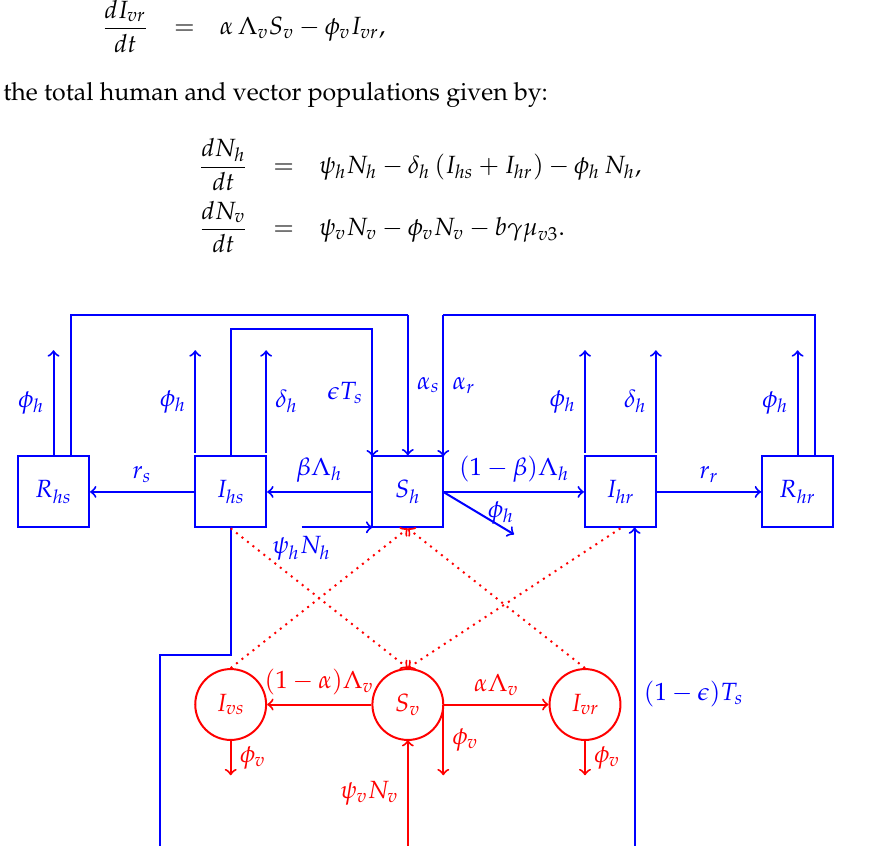
Figure 1. Susceptible humans S h can be infected by infectious mosquitoes. They then move to the respective infectious compartments, I hs , I hr , before entering the recovered classes R hs , R hr , respectively. Recovered humans can enter the susceptible class again or die. The susceptible mosquitoes, S v , can become infected when they bite infectious humans. The infected mosquitoes then move to one of the infected classes I vs , I vr